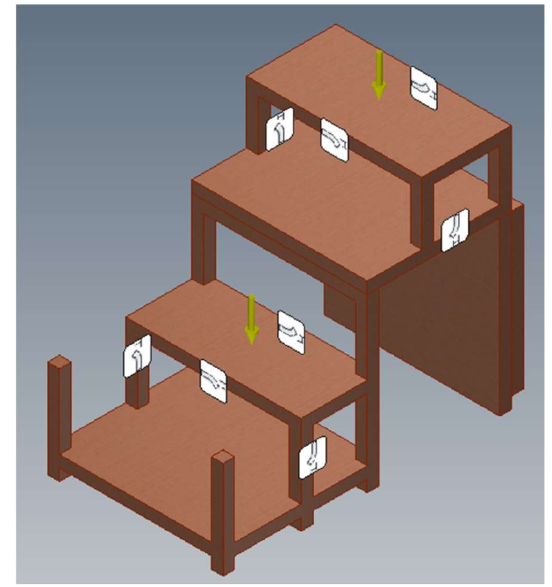
Figure 10. Overview of force applied on